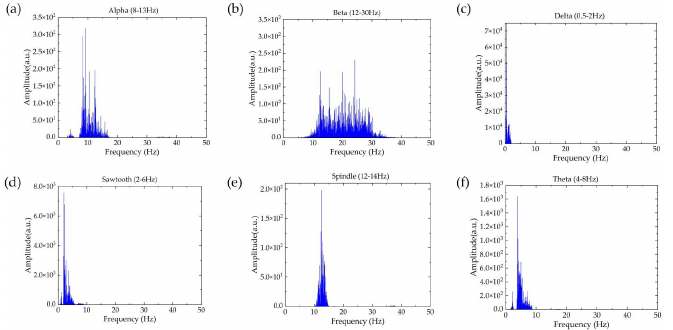
Figure A1. The frequency spectra of ( a ) Alpha, ( b ) Beta, ( c ) Delta, ( d ) Sawtooth, ( e ) Spindle, and ( f ) Theta, applied for computing frequency domain features.